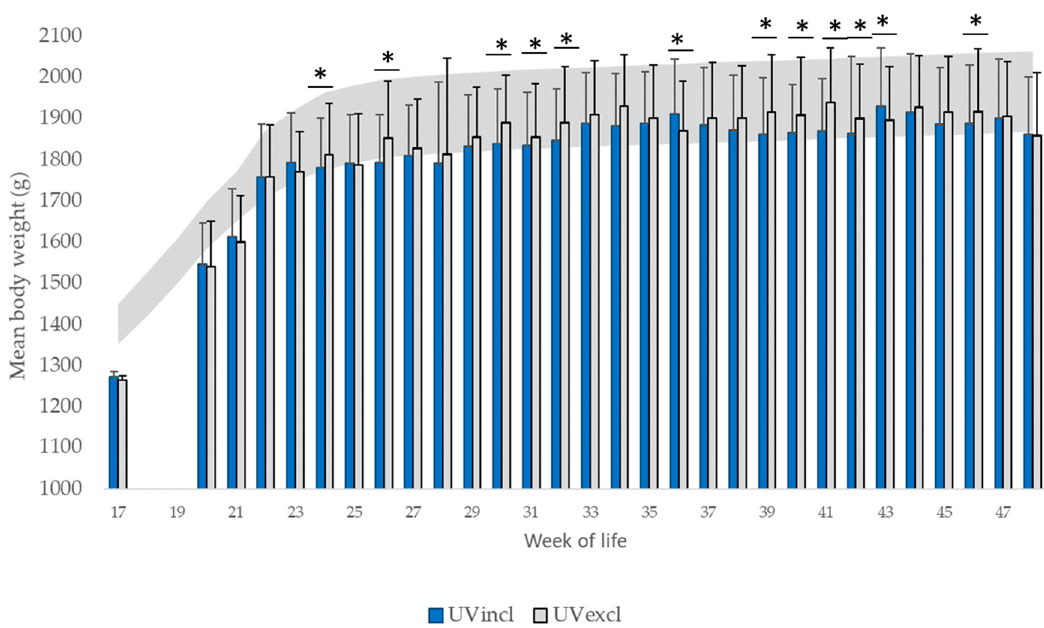
Figure 4. Mean body weight (g) at the end of rearing (17th WL) and during production (18th–48th week of life) in hens ( n = 200 hens/lighting group and week of life) as well as breeder’s recommendation of target minimum and maximum value for production (grey area). * Significant differences in the average live weight ( p < 0.05; WL: 24, 26, 30, 31, 32, 36, 39, 40, 41, 42, 43, 46).